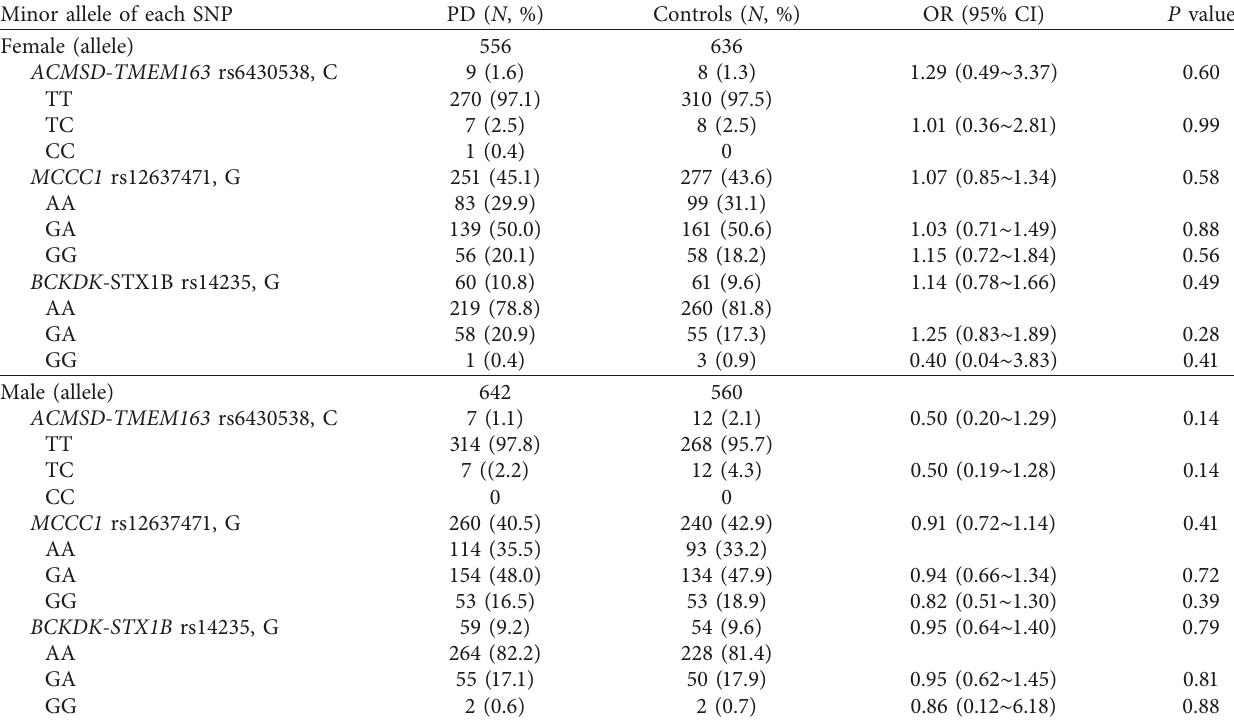
Table 4: Comparisons of minor allelic and genotypic frequencies of single nucleotide polymorphisms (SNPs) between female and male Parkinson’s disease (PD) patients and the controls.